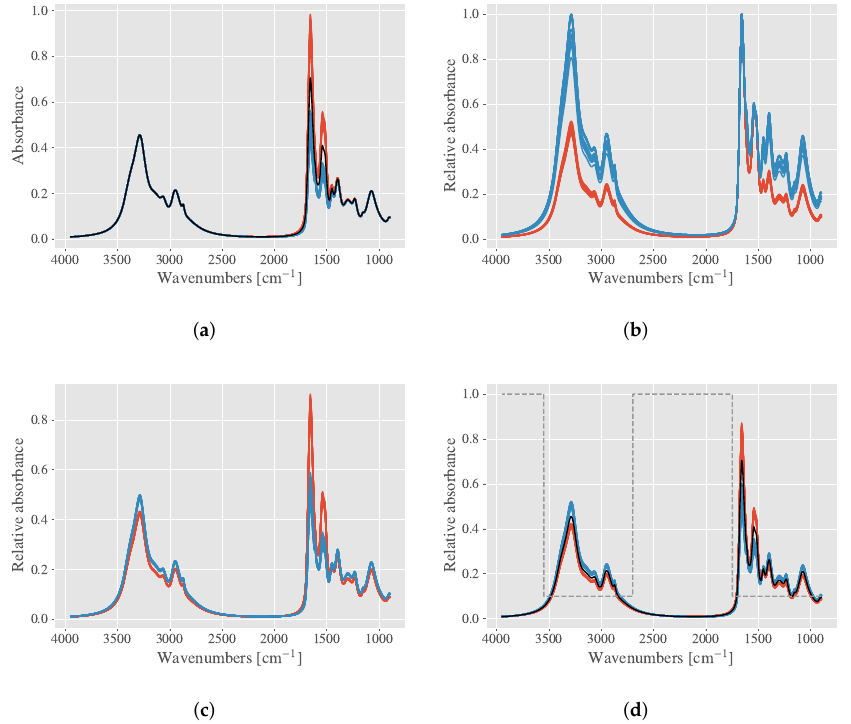
Figure 1. Different normalization procedures demonstrated on a simulated dataset. ( a ) Simulated spectra showing the two chemically different groups in different color. The groups are simulated with chemical differences in the amide I and II region. The mean spectrum is shown in black. ( b ) Peak normalization according to the amide I peak. ( c ) Vector normalization. ( d ) Weighted EMSC normalization is shown with weights in dashed gray. The mean spectrum in black is used as reference. Only a constant baseline was included in the EMSC